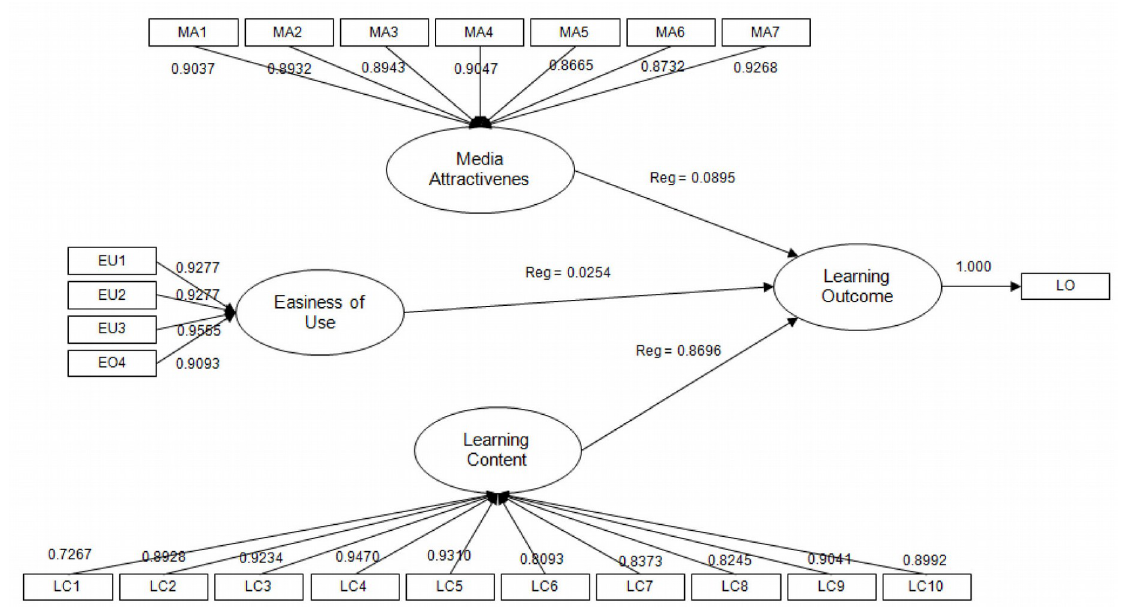
Figure 3. Result of modeling of utilizing signal coding technique based on GUI